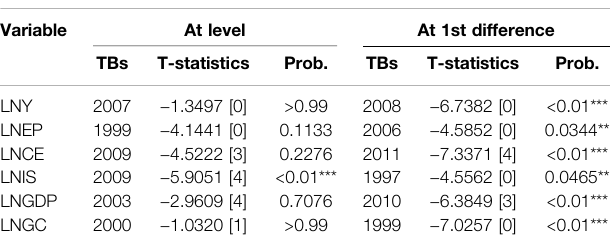
TABLE 3 | Breakpoint unit root